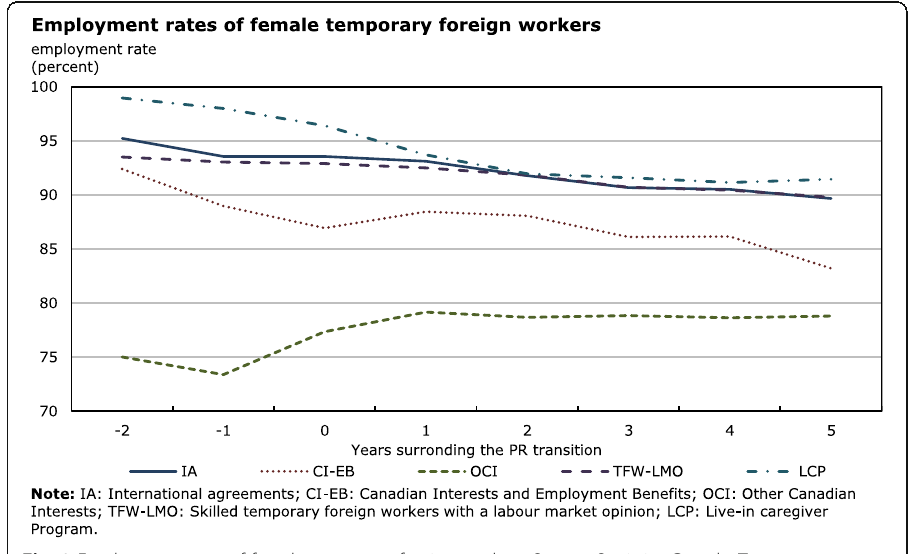
Fig. 2 Employment rates of female temporary foreign workers. Source: Statistics Canada, Temporary Residents file, Immigrant Landing file and Canadian Employer-Employee Dynamics Database